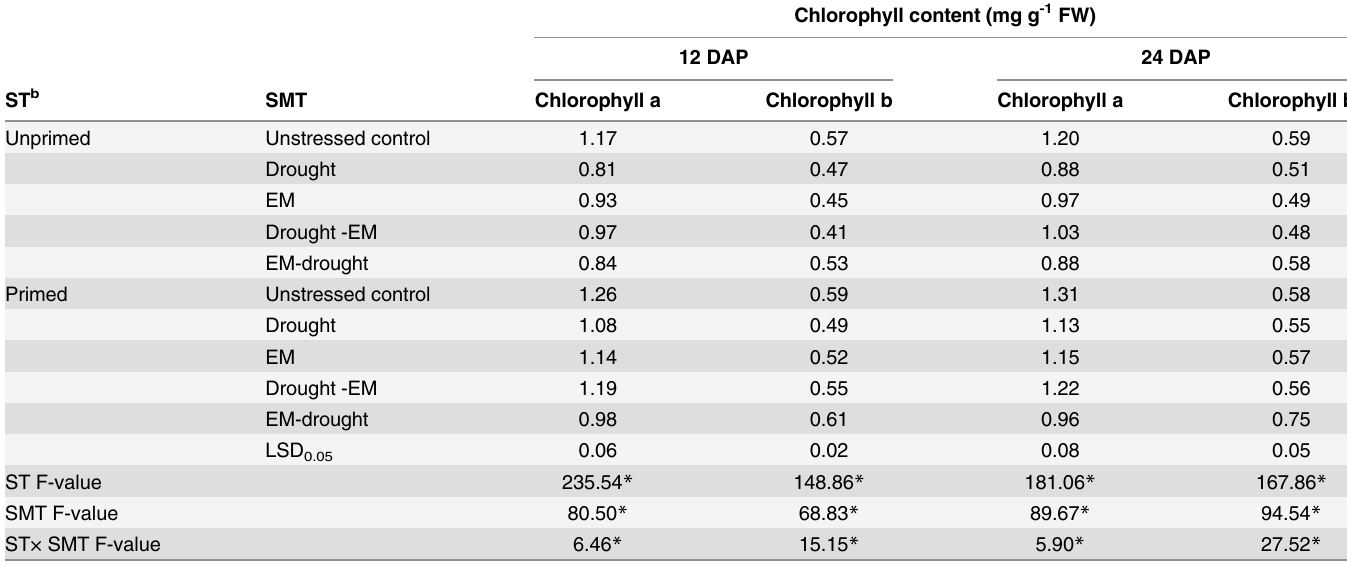
Table 3. Effect of seed priming with PEG and soil moisture stress on chlorophyll content in sorghum